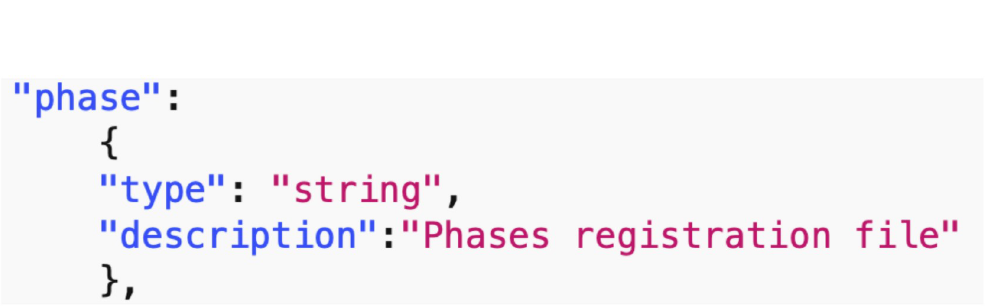
Fig 25. To run a pipeline (called a job), a configuration input file specifies functions and their order of execution. This Figure shows a portion of the schema for a configuration file that specifies the phase description JSON schema file location.